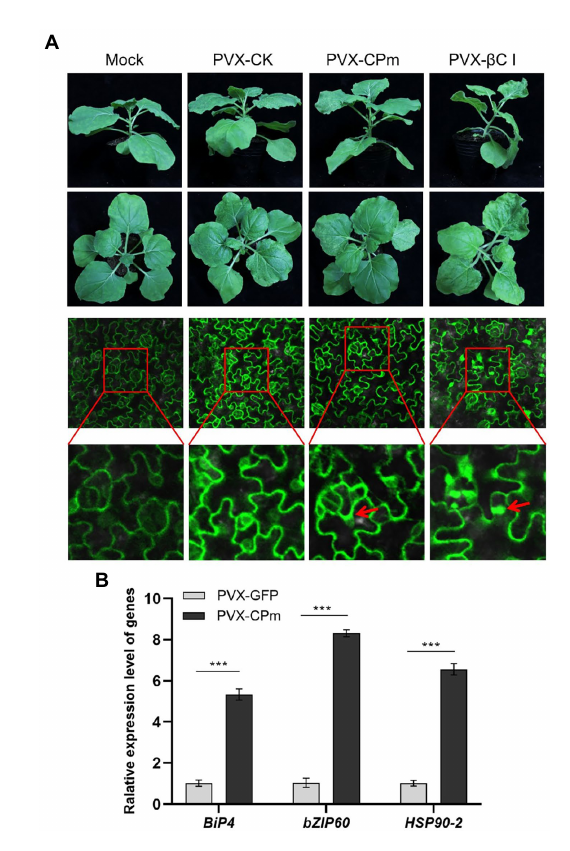
FIGURE 3 Endoplasmic reticulum (ER)-body and relative mRNA levels of the indicated ER-stress marker genes in CPm -expressing Nicotiana benthamiana 16c plants. (A) Symptoms and ER-body induced in leaves of N. benthamiana 16c plants induced by PVX-CPm. (B) Relative mRNA levels of ER-localized binding ( Bip ), Heat shock 90–2 ( HSP90-2 ), and basic leucinezipper 60 ( bZIP60 ) were measured in Potato virus X (PVX)-CPm and PVX-GFP vector-infected N. benthamiana 16c plants at 14 days post inoculation (dpi) by RT- qPCR. Values are the mean ± SD. Highly significant differences (*** ρ < 0.001) between samples in each pair are indicated.